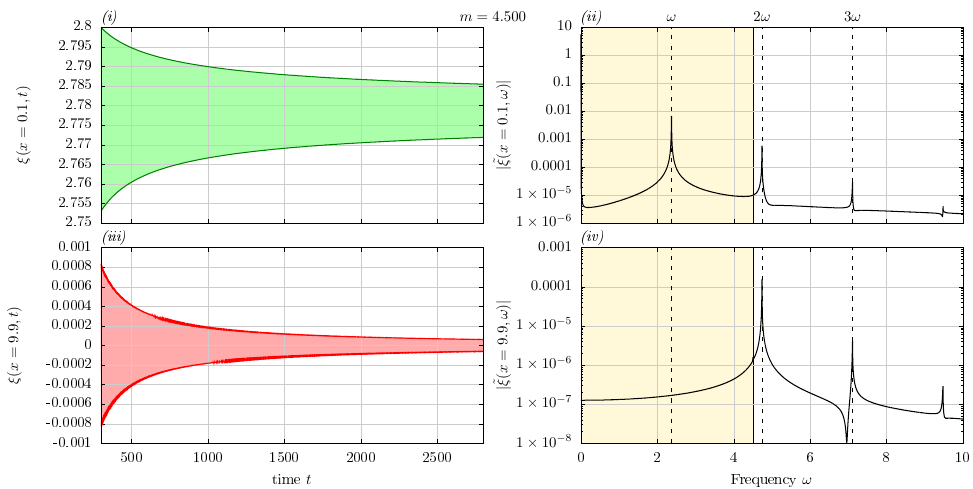
Figure 9 . Normal decay of the oscillational mode for the p = 2 case through the second harmonics. The left panels show the time dependence of the (cid:12)eld oscillations near the center (i) and at a certain distance from the skyrmion core (iii) . The right panels show the power spectrum of the oscillations. m = 5 . 500